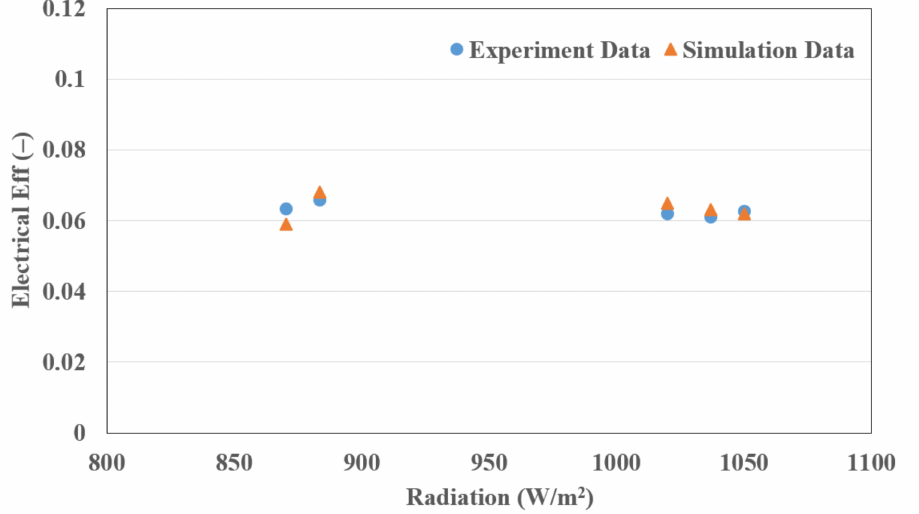
Figure 9. Comparison of electrical efficiencies for experimental and simulation